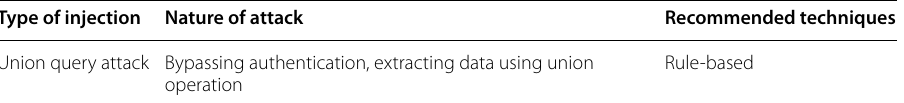
Table 2 Union injection attack [54] Type of injection Nature of